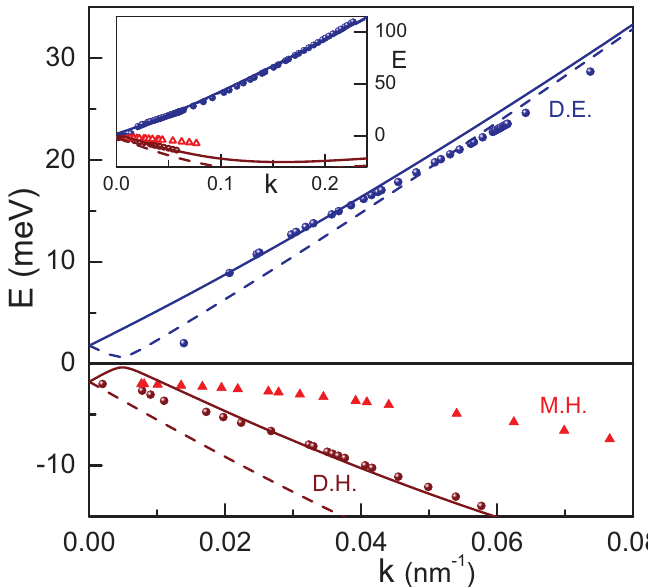
Figure 4. Band structure of HgTe films with critical thickness. Symbols are experimental data from two samples, lines— k · p theory. The symbol notations are the same as in Figure3. The solid and dashed lines are split bands due to asymmetric potential and to bulk inversion asymmetry. The different slope of electrons and holes is due to a lifted hole degeneracy. The inset shows the overview over the data on a large energy scale. The flattening of the hole dispersion at high values of k is due to approaching of the hole pockets around k ∼ 0.5nm − 1 , E ∼ −